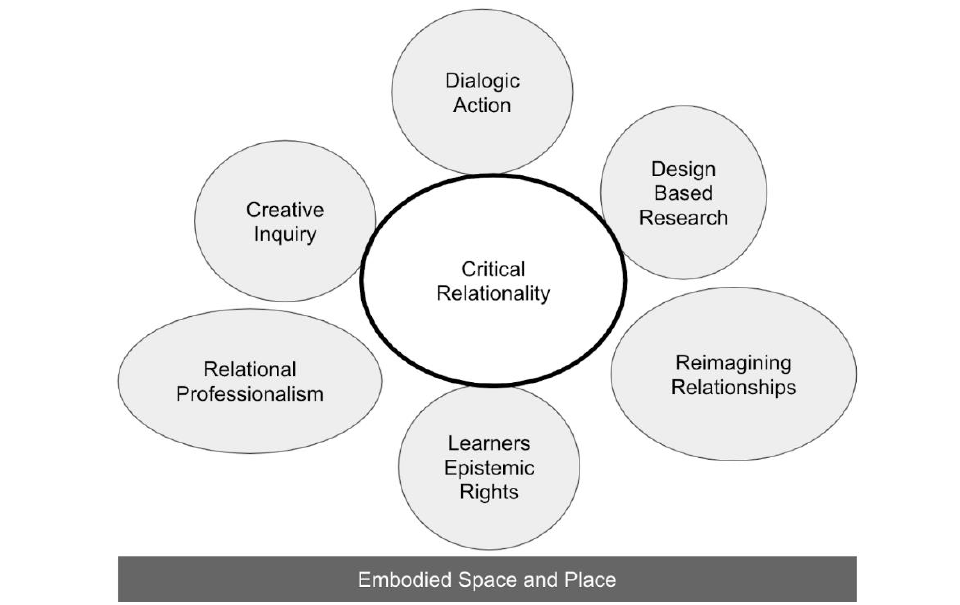
Figure 1: Critical Relationality